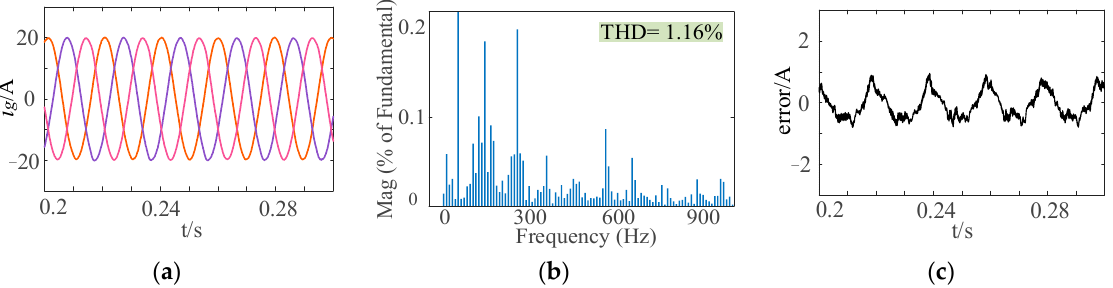
Figure 17. Simulation results of Newton-FOPRRC at 50.8 Hz: ( a ) Grid current i g . ( b ) Harmonic spectrum of i g_c . ( c ) Current tracking error ɛ .